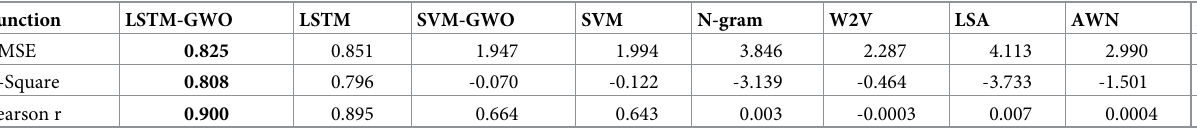
Table 7. Comparison of the proposed model and compared models with experiment 3.